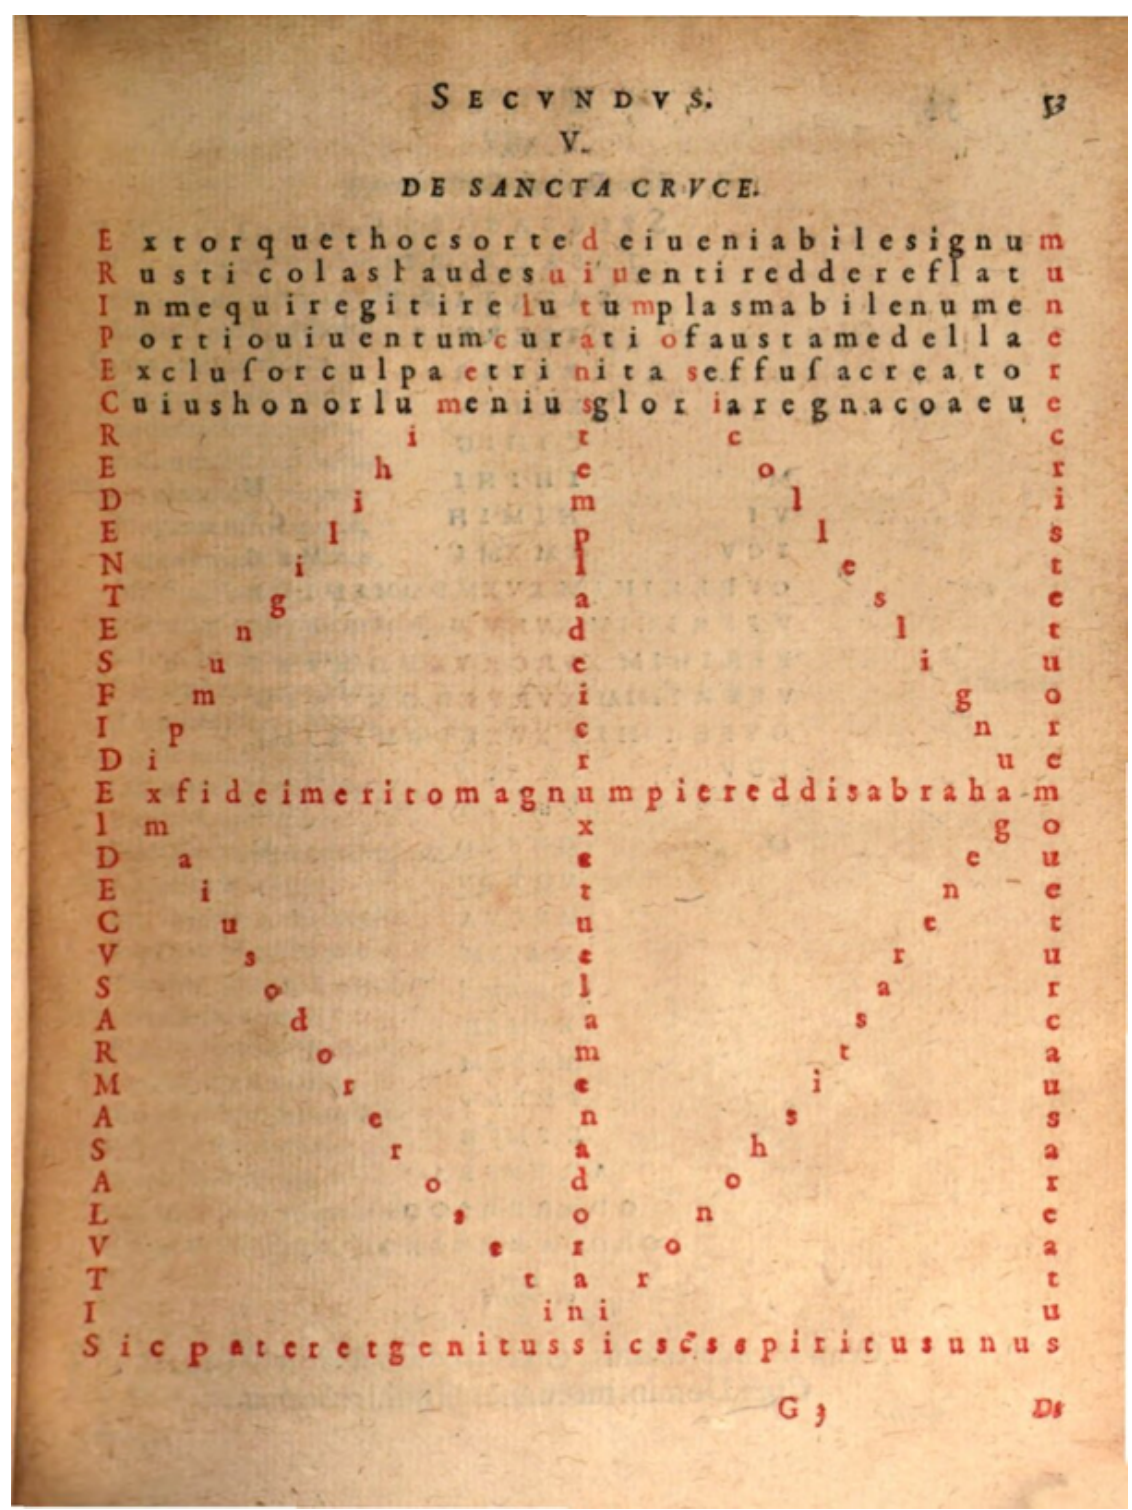
Figure 2 Bayerische Staatsbibliothek München, 4 P. lat. 426, S. 53,